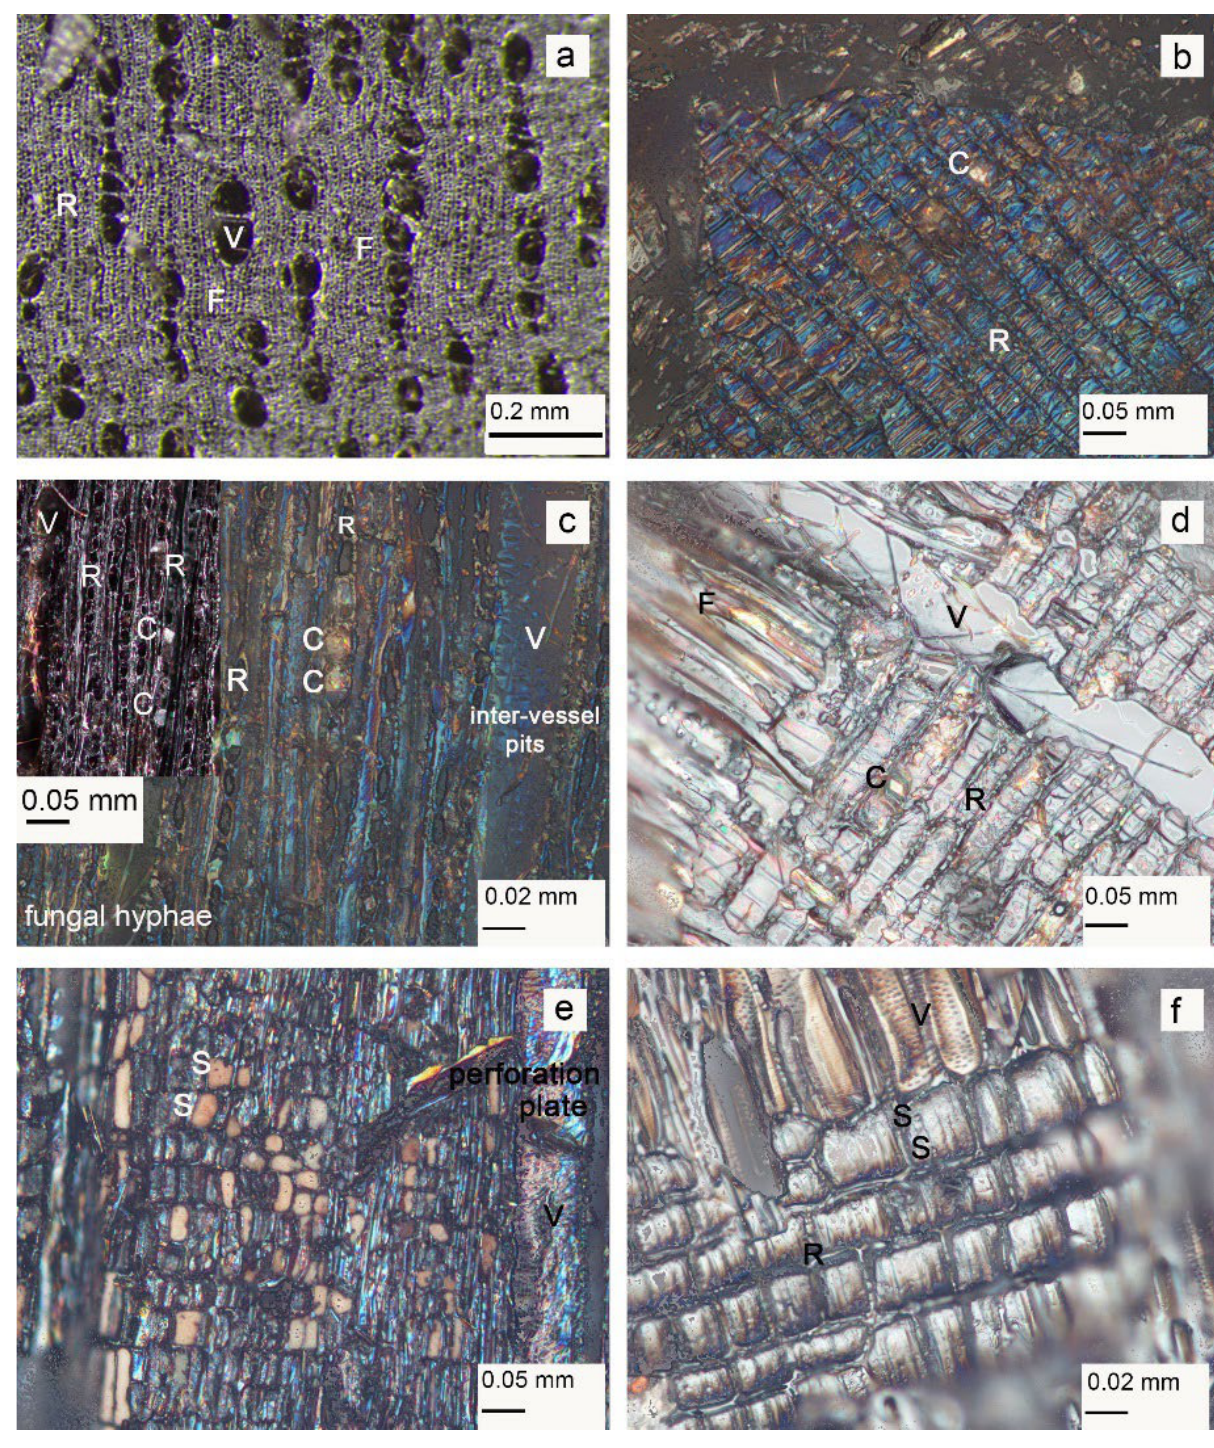
Figure 1: Diagnostic characteristics of charcoal reference material: (a–c) Spirostachys africana (SJL 103), (d) Spirostachys africana (NDO), (e) S clerocroton integerrimus (SJL 88) and (f) Shirakiopsis elliptica (SJL 67). (a) In transverse section, Spirostachys africana has many small vessels (V) in long lines. Vessels are occasionally in pairs. The shiny cell contents may be resin 2 or gum 30 . These fibres (F) are thin-walled and regular. (b) The radial longitudinal section has crystals labelled (C) in the ray cells, which shine under polarised light. Ray cells (R) are mixed; the procumbent cells are as high as the square cells and occasionally there are upright cells in the margins. The rays are low. (c) The tangential longitudinal section has frequent, uniseriate rays. The prismatic crystals of calcium oxalate in ray cells which distinguish Spirostachys shine under polarised light. Vessels with alternate inter-vessel pits occur and the vessel walls are birefringent under polarised light. The insert shows these ray crystals at a lower magnification. (d) Inferred Spirostachys africana reference material from Ndondondwane, KwaZulu-Natal (NDO) has prismatic, rhombic, crystals in the ray cells which shine under non-polarised light, in radial longitudinal section. (e) In S clerocroton integerrimus reference material , SJL 88, there are silica bodies labelled (S) in the ray cells. These are spheroidal or irregularly shaped particles which are opaque under polarised light. The ray cells are heterocellular, mixed procumbent, square and upright in radial longitudinal section. The cell walls of the vessels, rays and fibres are birefringent in polarised light. (f) In Shirakiopsis elliptica reference material, SJL 67, the silica bodies (S) in ray cells are granular, dark spots. Rays are heterocellular with upright and square cells seen in radial longitudinal section. These inter-vessel pits are